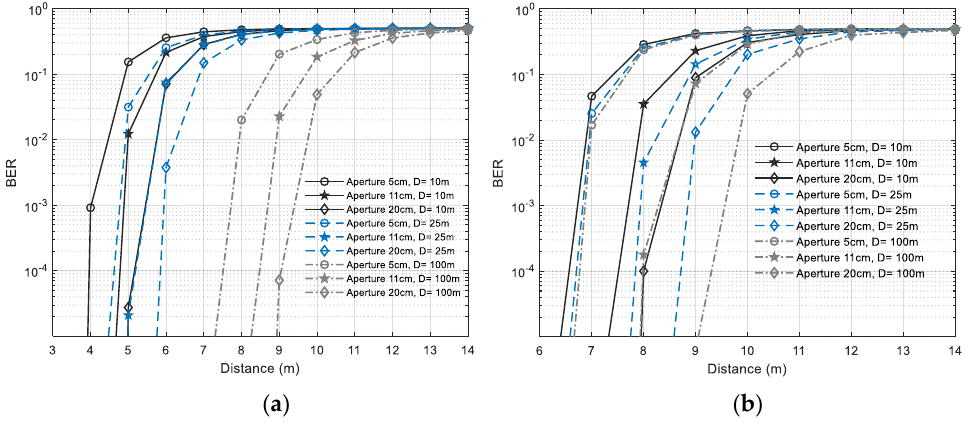
Figure 12. BER performance versus communication distance with different apertures and operation depths in turbid harbor water for ( a ) FOV = 180°, ( b ) FOV = 15°.